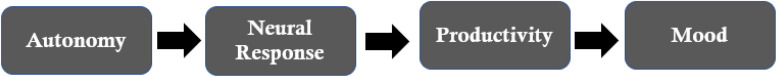
The causal model the experiment will test.